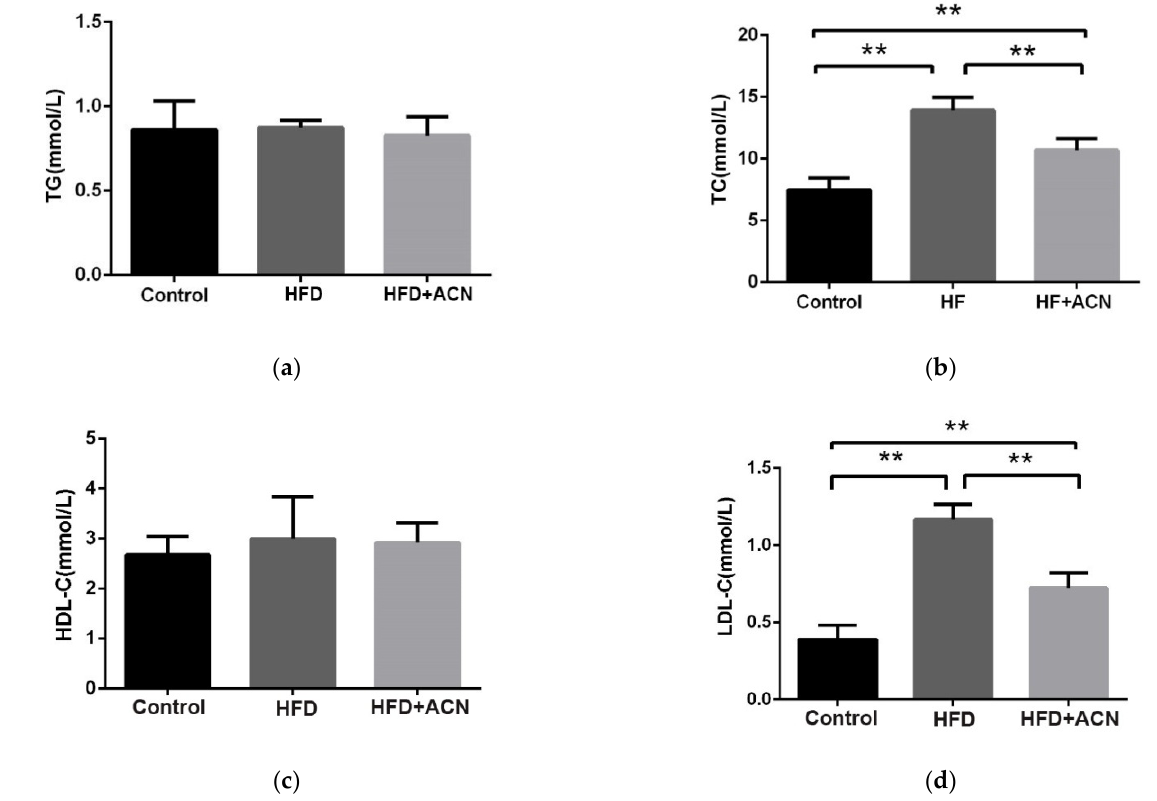
Figure 2. The effects of anthocyanin extract from the fruits of L. ruthenicum on the serum lipid levels in high-fat-fed C57BL/6 mice. Data are expressed as the mean ± SD ( n = 8 for each group), ** denotes p < 0.01. ( a ) TG. ( b ) TC. ( c ) HDL-C. ( d ) LDL-C.